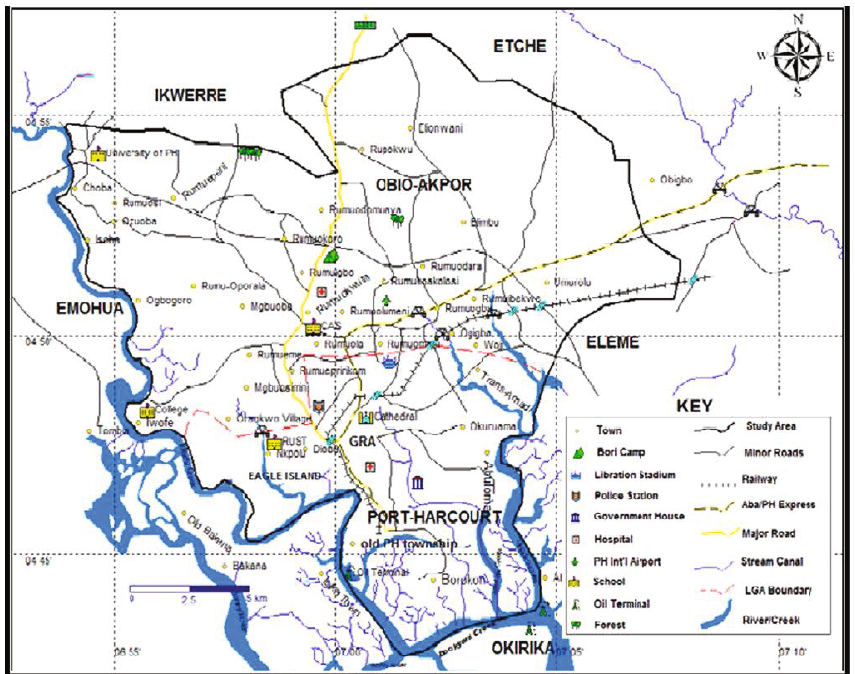
Figure 3: Map of Port Harcourt metropolis. Source: